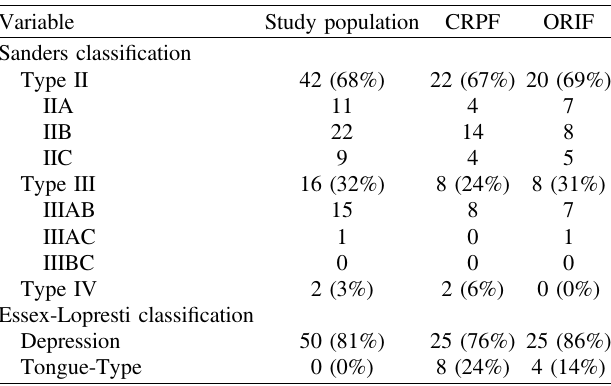
Table 2. Preoperative Sanders and Essex-Lopresti classi fi cation of calcaneus fractures in ORIF and CRPF groups.